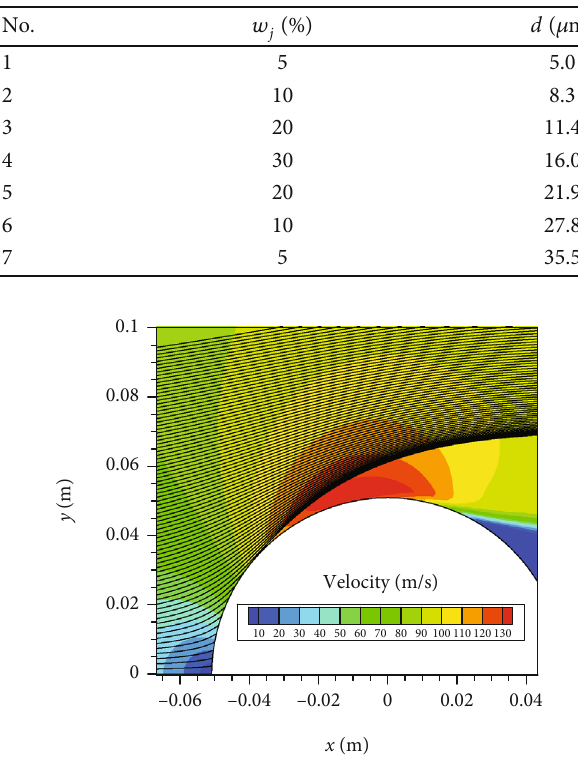
Figure 2: Lagrangian droplet trajectories on contour of air velocity around the cylinder at the droplet diameter of 16 μ m.